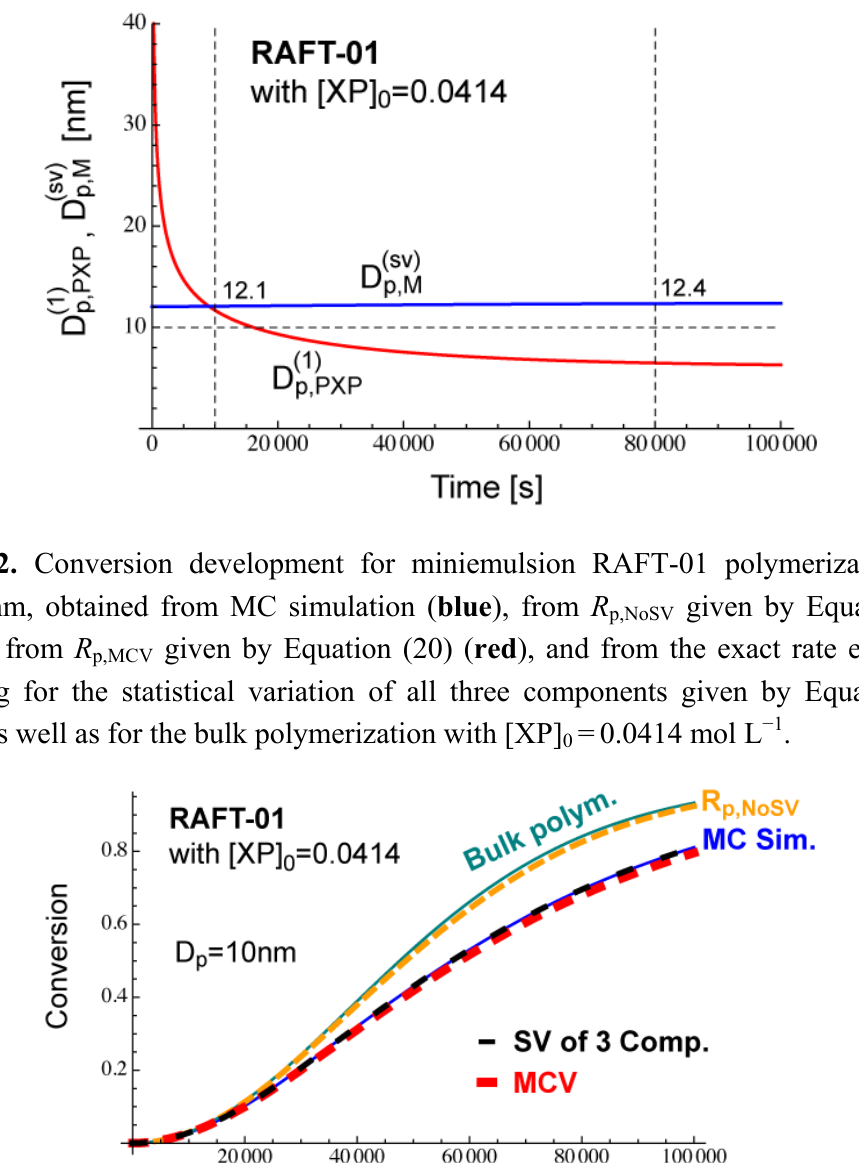
= 0.0414 mol L − 1 . 0